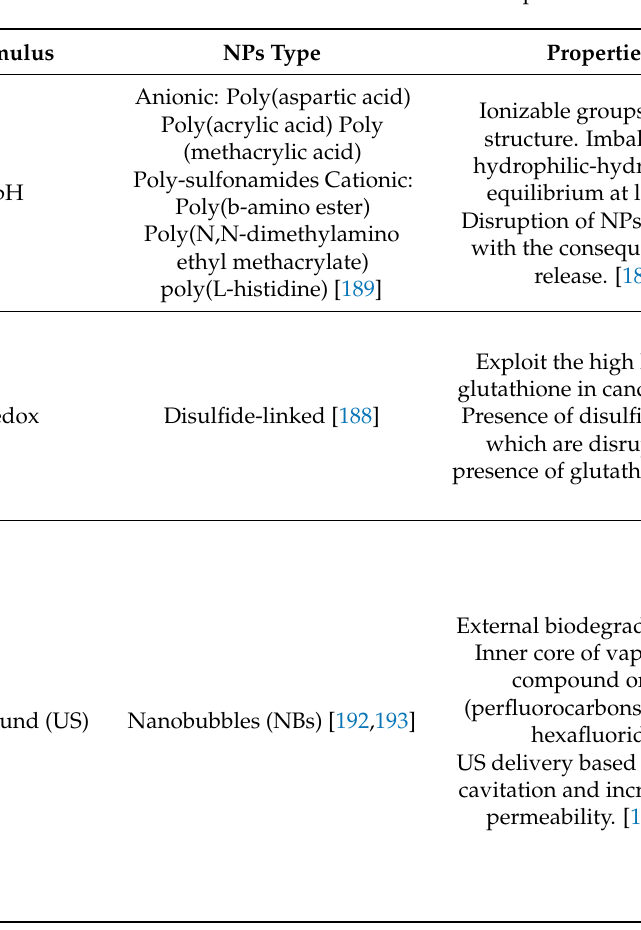
Table 3. NPs with stimuli-responsive drug